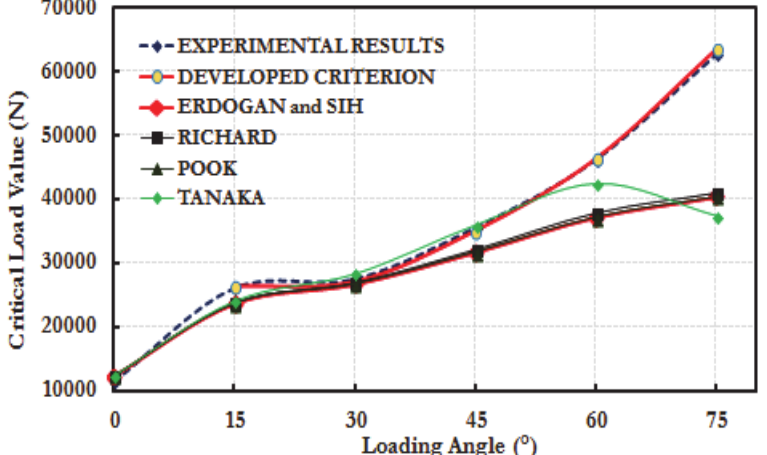
Figure 1: Comparisons of experimental and predicted CTS specimen fracture